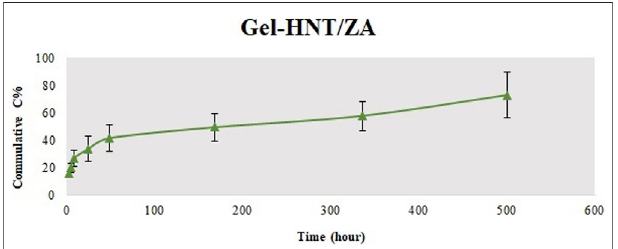
FIGURE 5 | ZA release behavior from the Gel-HNT/ZA.